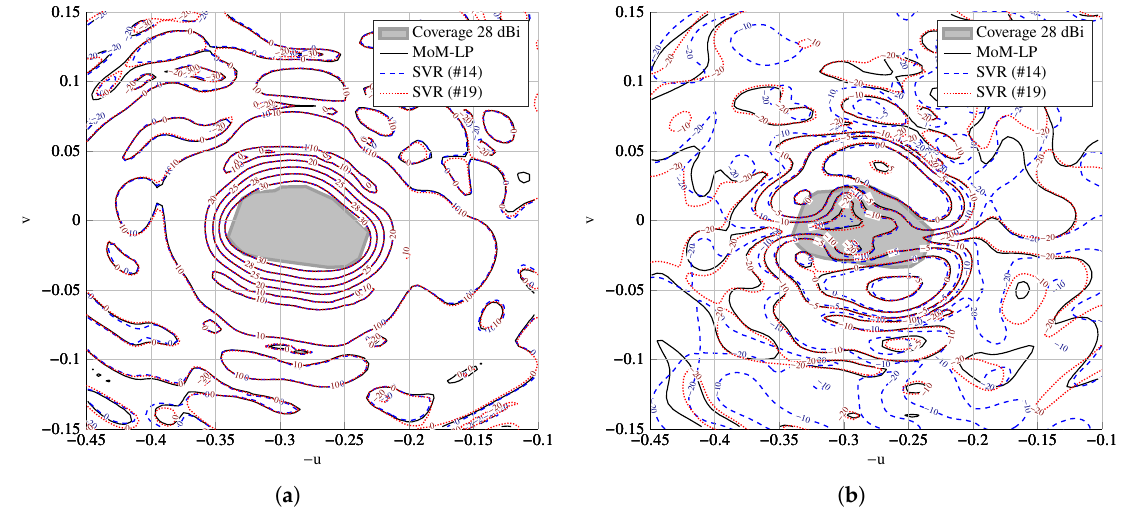
Figure 9. Comparison of the MoM-LP simulation and SVR predictions for the ( a ) copolar and ( b ) crosspolar patterns for polarization V of a very large reflectarray with European coverage for DTH application.